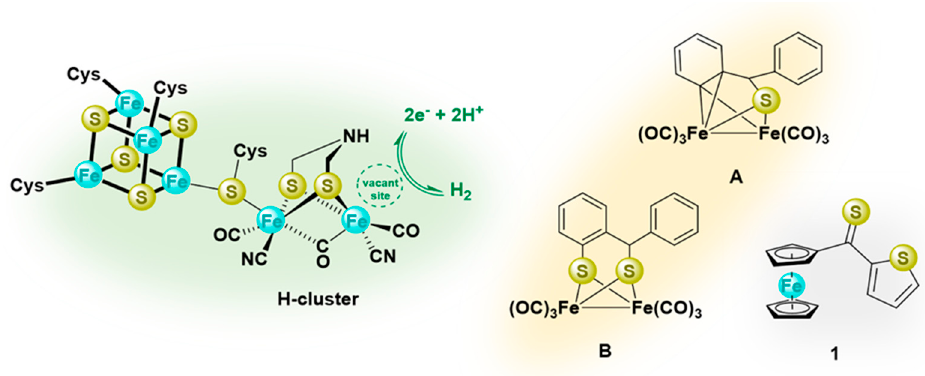
Figure 1. Presentation of the H-cluster ( left ); sulfur − iron complexes derived from thioketones, com- monly considered models of the active site of [FeFe] − hydrogenase (middle, A and B ), and structural formula of ferrocenyl α -thienyl thioketone ( 1 ) ( right ).